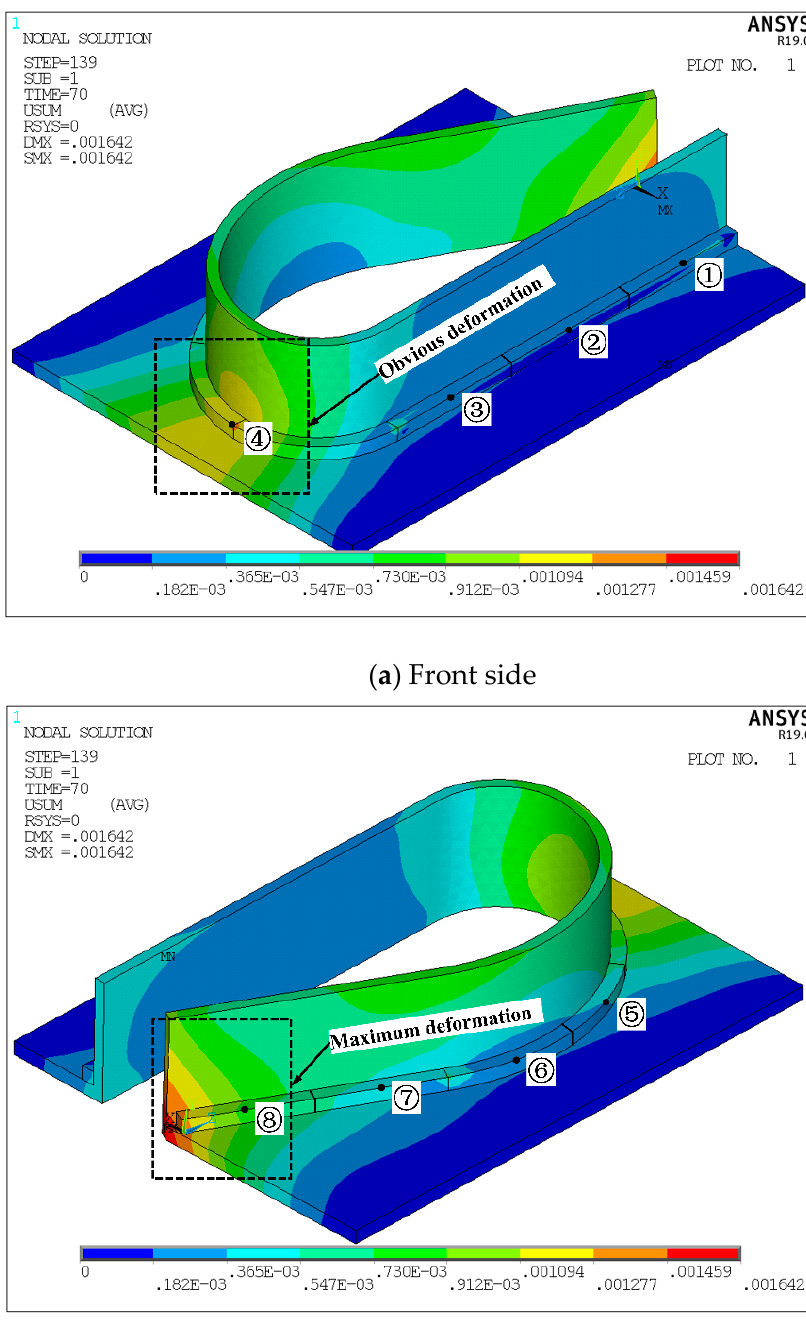
Figure 12. Total deformation cloud map of welded structure 4 under the optimal welding sequence.